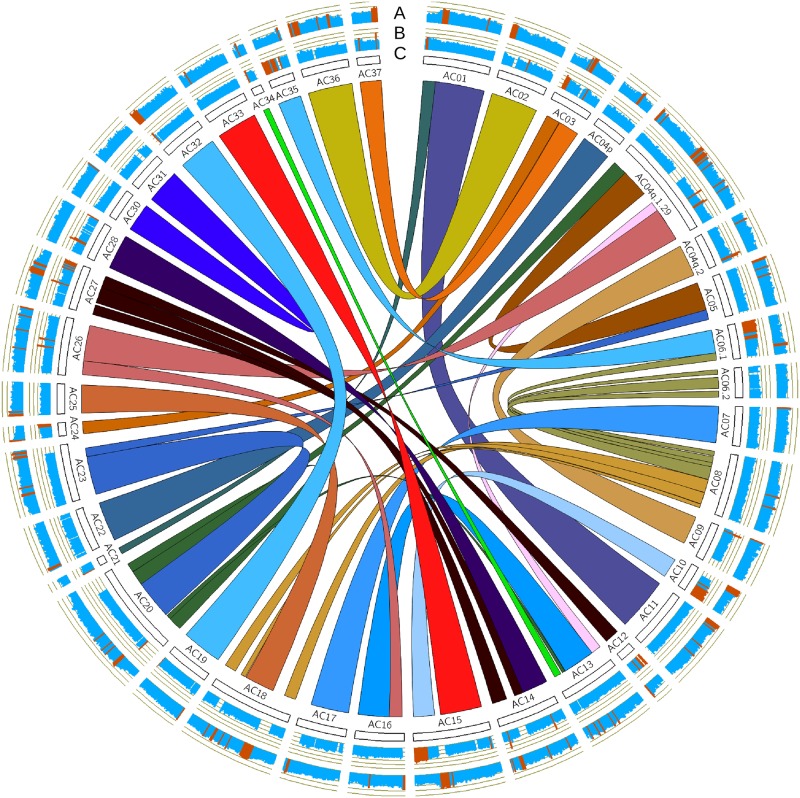
Circos plot of Arctic charr genome assembly.A) Is comprised of bar charts for each chromosome with the fraction of repetitive DNA found in million bp windows with a scale from 0 to 1 (bars with scores greater than 0.65 are shown in orange). B) Displays bar charts of percent identity between homeologous regions defined by SyMap v4.2. The percent identity was found by weighting the percent identity by alignment lengths. Each bar represents a million bp window, and the y-axis starts at 75 percent and ends at 100 percent identity. Windows with score greater than 90 percent were highlighted orange. C) Ideograms of each of the Arctic charr chromosomes. The internal ribbons link homeologous (or duplicated) regions of the genome.